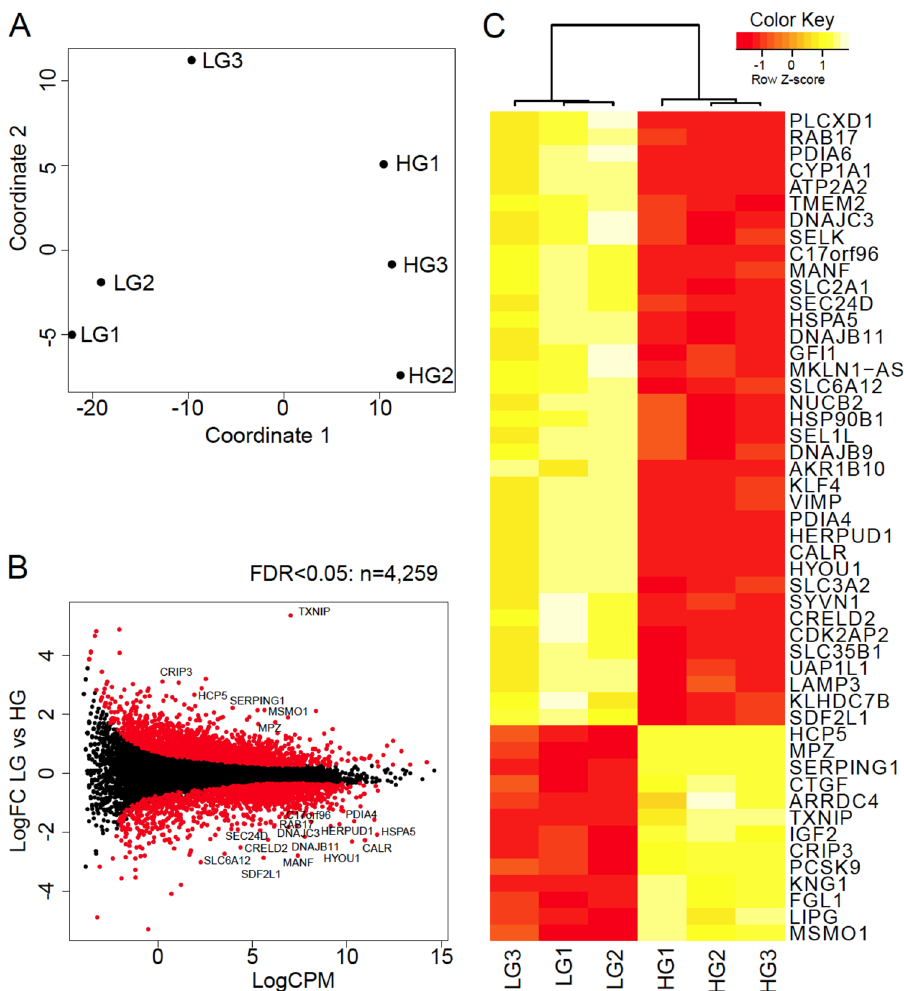
Figure 1. RNA-seq identifies gene expression changes due to high glucose exposure in HepG2 cells. ( A ) Multidimensional scaling analysis shows sample clustering based upon treatment. ( B ) Smear plot depicts the log2 fold change and average expression level log2 counts per million for each detected gene. Genes with differential expression (FDR ≤ 0.05) are highlighted in red. ( C ) Heatmap of the 50 most significant differentially